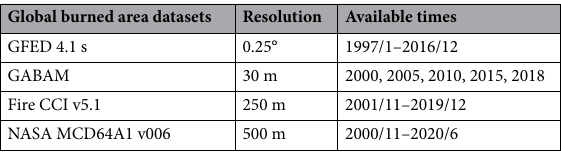
Table 2. Information for the candidate global burned area datasets.